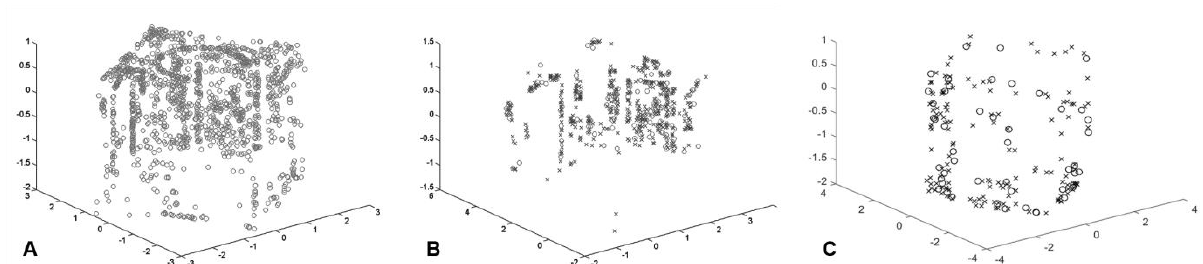
Figure 3. The distribution of the tie points for the worst case (Test site I): A) 2D detector and orthoimage, B) 2D detector and spherical image, C) 3D detector and point